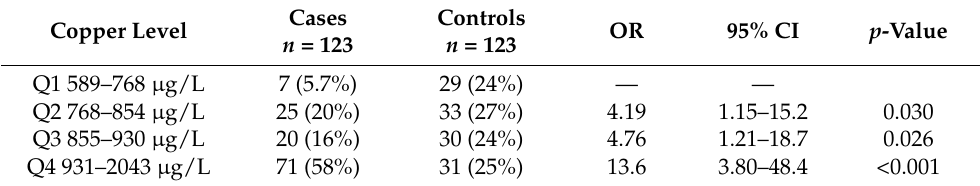
Table 8. Blood copper levels and the occurrence of colorectal cancer among G1-G2 patients.